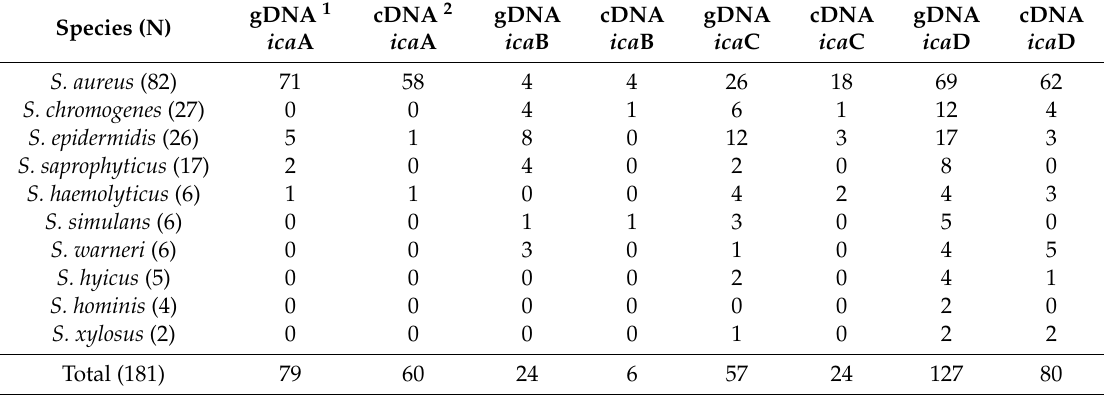
Table 1. Distribution of detection (gDNA) and expression (cDNA) of genes involved in biofilm formation according to Staphylococcus species.